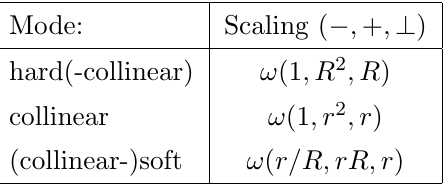
Table 1 . Modes and power counting in SCET that describe the momentum fraction of the central subjet in the regime r (cid:28) R